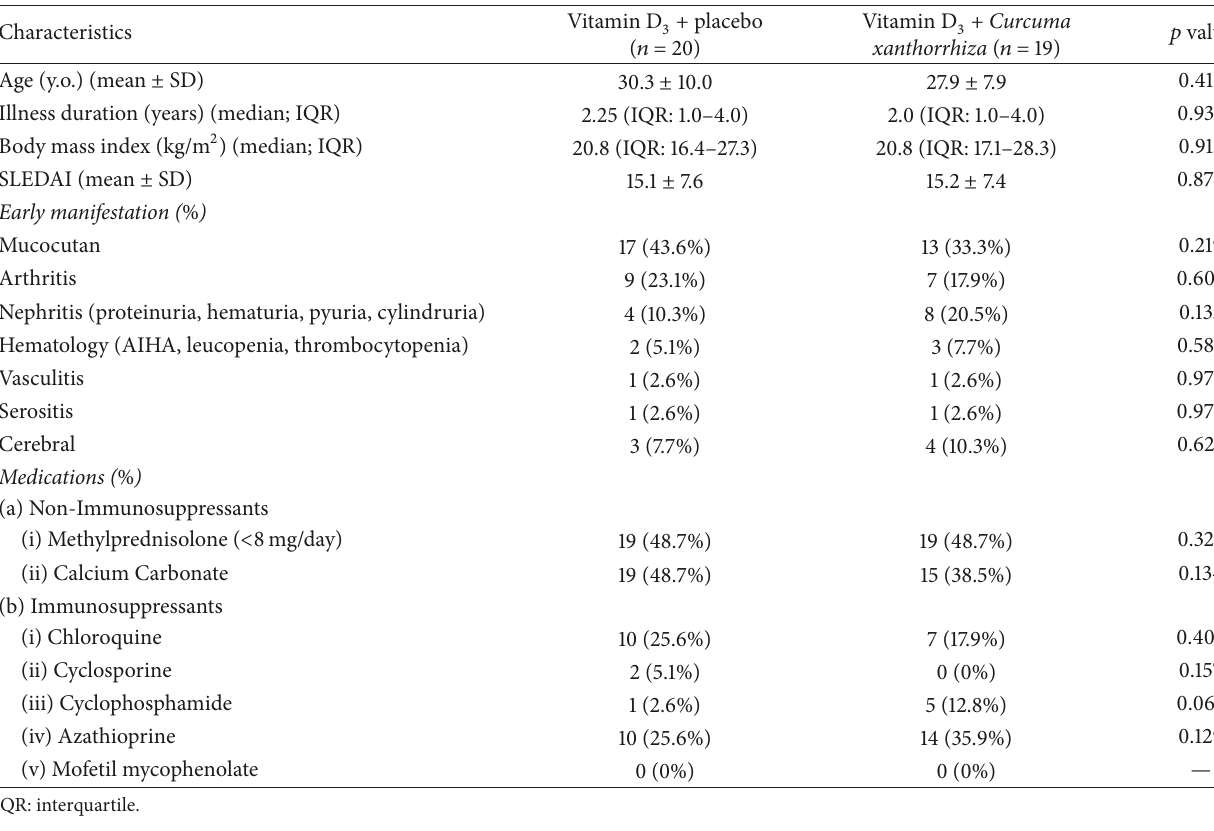
Table 1: Baseline characteristics of subjects.